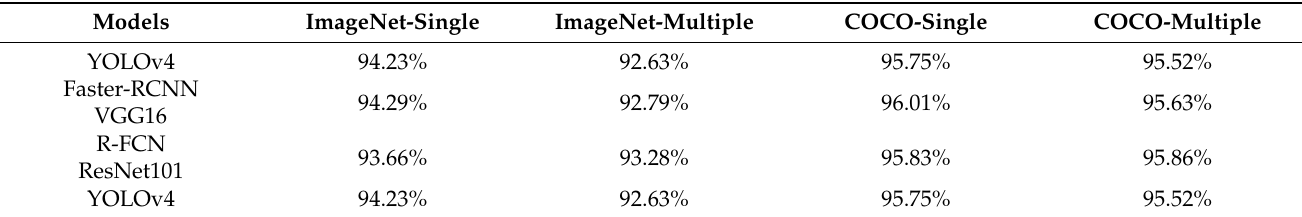
Table 2. Detection accuracy of different object